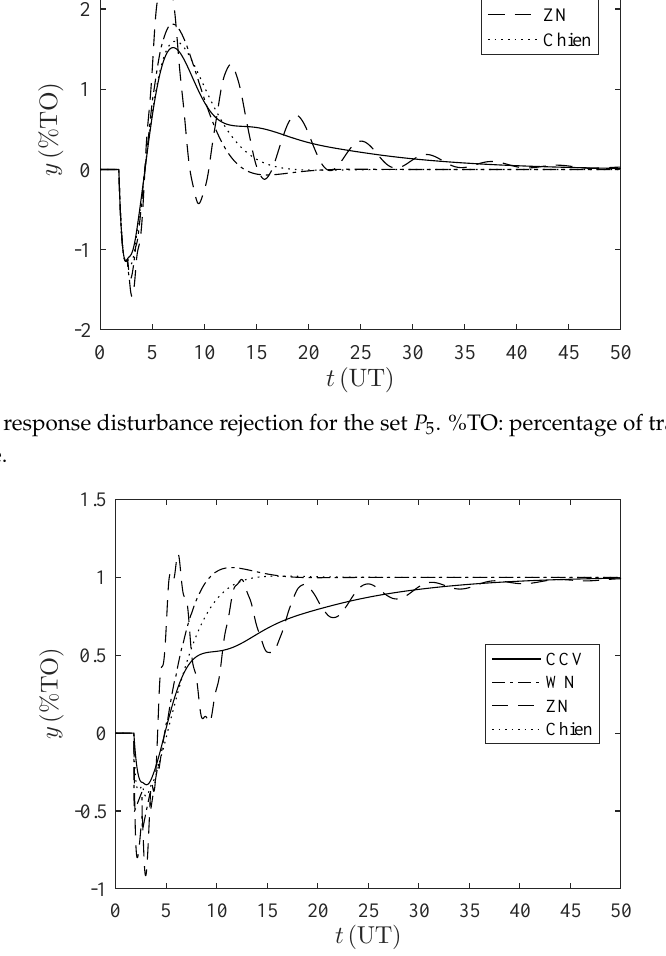
Figure A8. Time response set-point tracking for the set P 5 . %TO: percentage of transmitter output, UT: units of time.